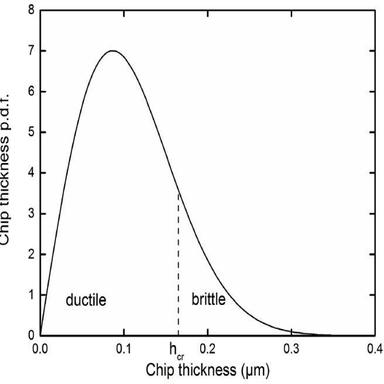
Schematic diagram of RB-SiC surface features produced in grinding.